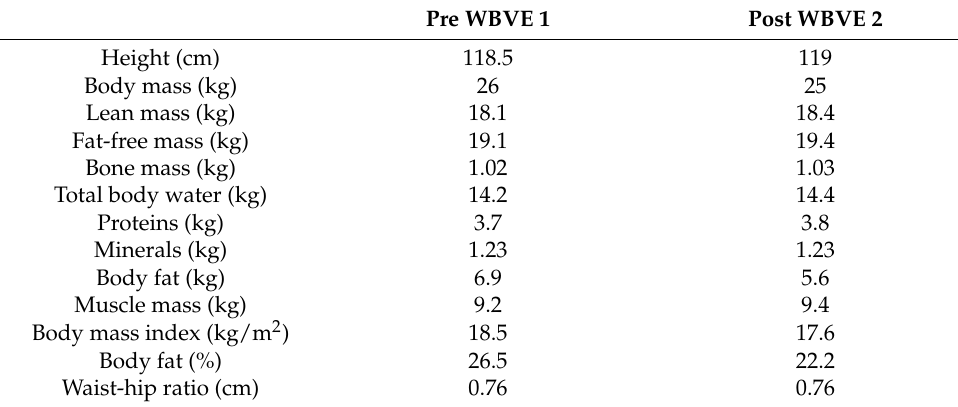
Table 5. Body composition parameters on the WBVE